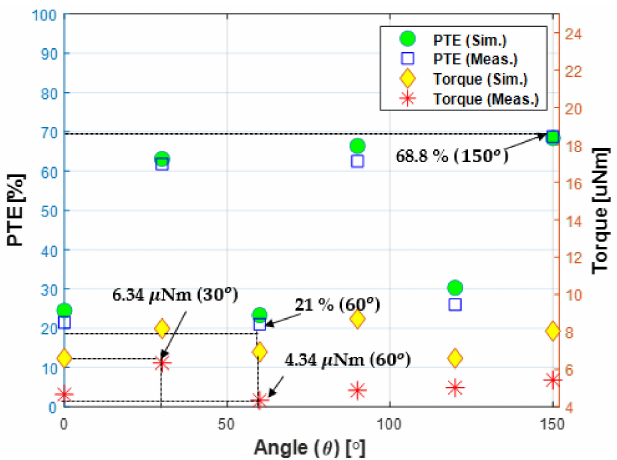
Figure 11. Simulation and experimental result of power transfer efficiency and torque of the proposed system. The power transfer efficiency varies from at least 21% to 68.8%, and the torque varies from 6.01 µ Nm to 8.78 µ Nm, which is relatively